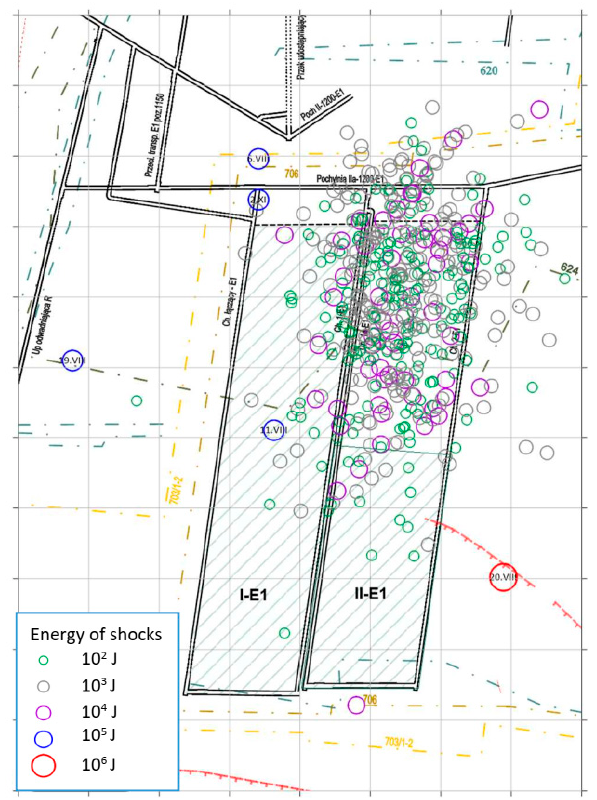
Figure 4. The placement of seismic activities during the exploitation of coal seam 713/1-2 at longwall II-E1 during the period of DHF performance from July 9th until November 19, 2017.